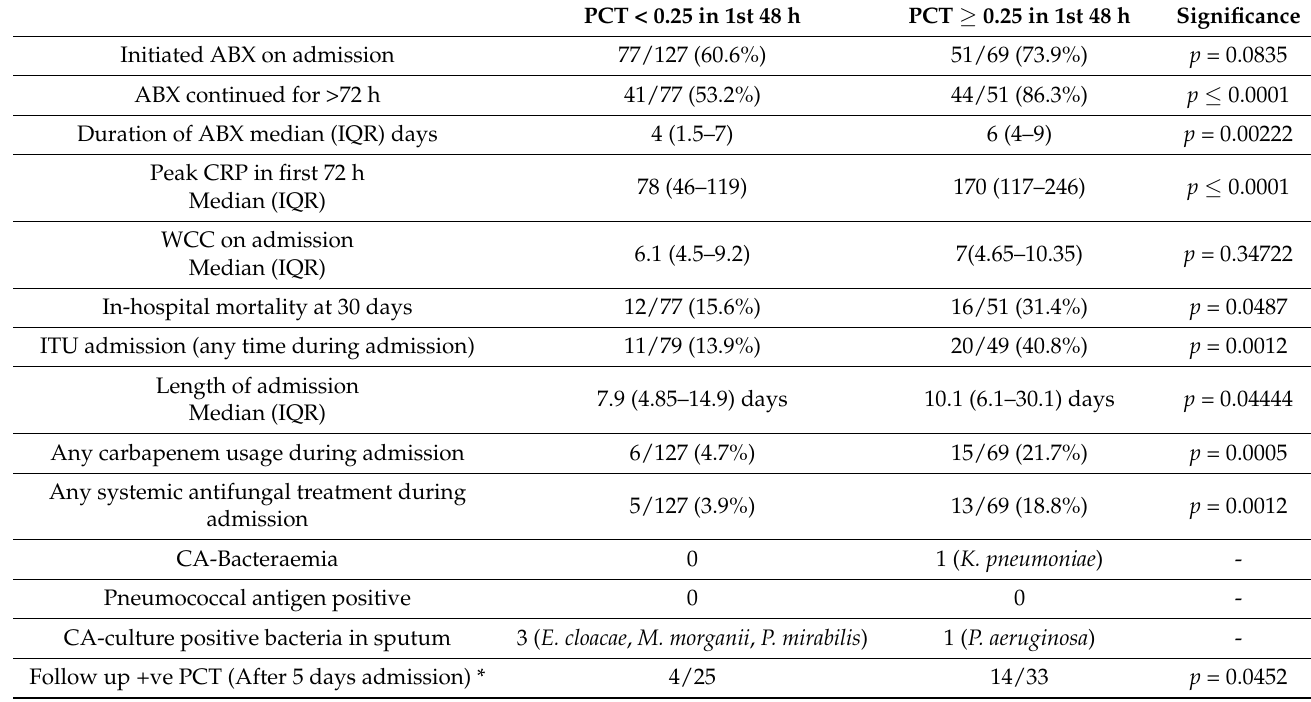
Table 2. Antibacterial usage on admission for patients presenting with community acquired pneumonia, London,